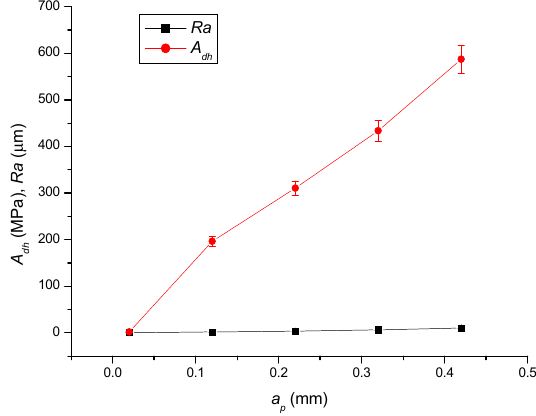
Figure 6. Dependence of adhesiveness and surface roughness on the depth of cut.